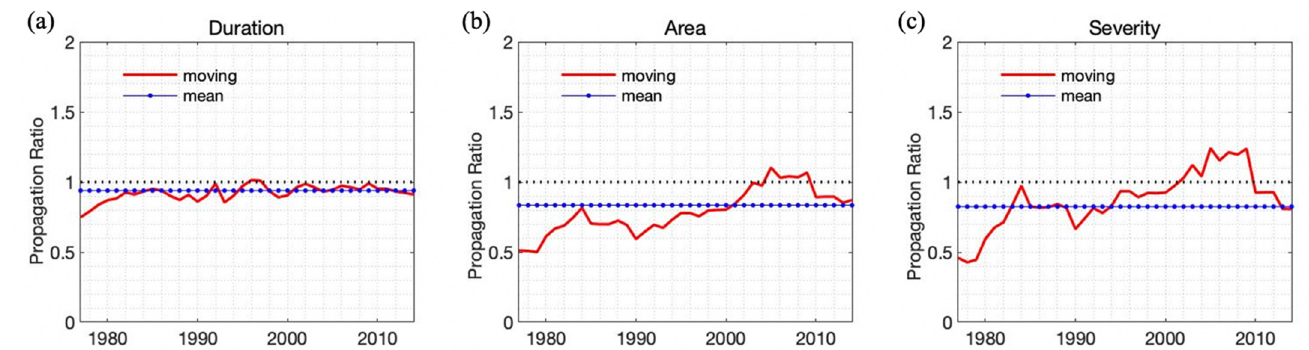
Figure 9. The moving propagation ratios of the drought parameters. the x -axis refers to the end of the corresponding moving window, as 1977 refers to the propagation ratio calculated from 1948 to 1977. The dashed blue lines are the constant propagation ratios calculated in Section 4.1, and the red lines are the moving propagation ratios in the corresponding moving windows as introduced in Section 4.2. The dashed black lines show the position of 1. ( a ) shows the propagation ratio of drought duration; ( b ) shows the propagation ratio of drought area; ( c ) shows the propagation ratio of drought